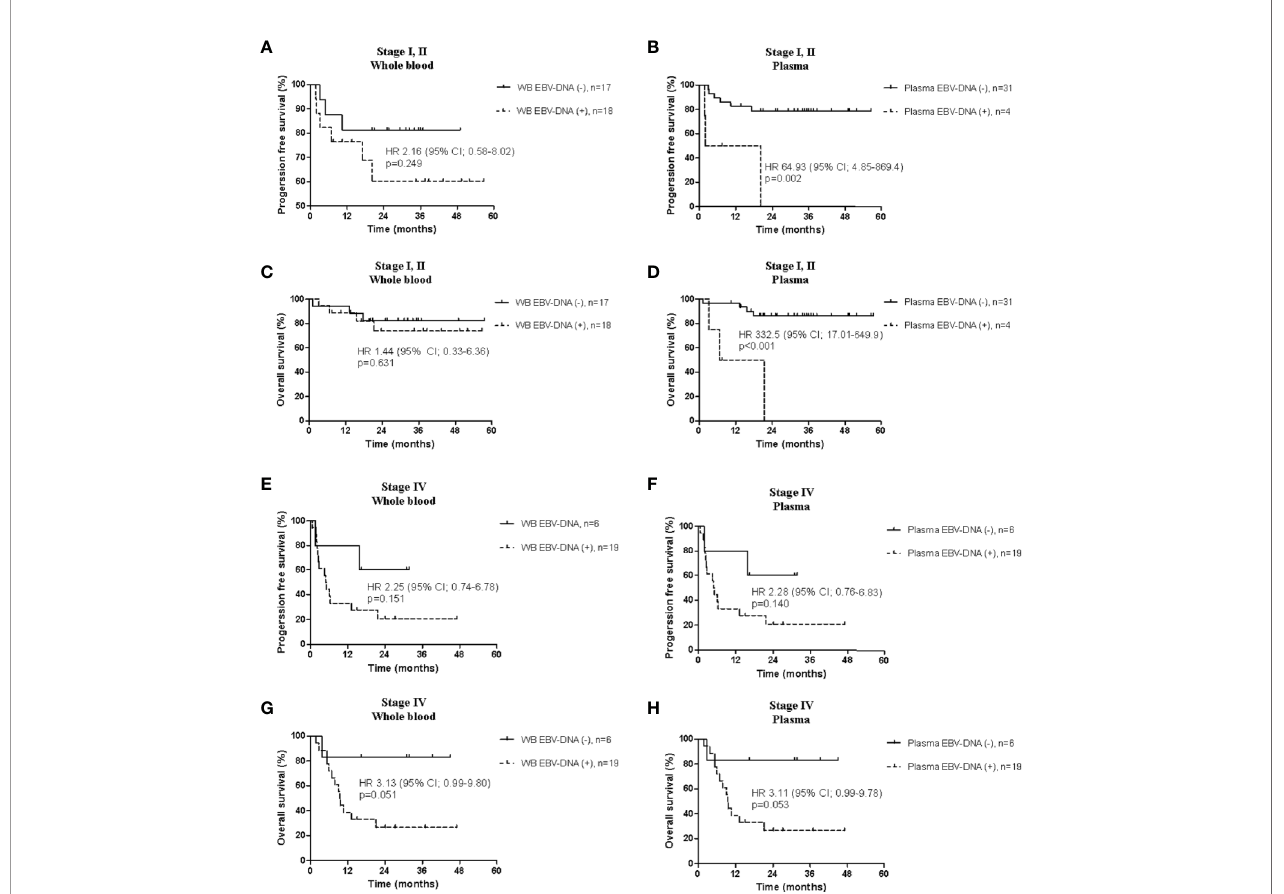
FIGURE 4 | Comparison of survival analysis between the whole blood and plasma in limited stage and advanced stage. Progression-free survival according to (A) whole blood and (B) plasma Epstein-Barr virus (EBV)-DNA, and overall survival according to (C) whole blood and (D) plasma EBV-DNA in limited disease. Progression-free survival according to (E) whole blood and (F) plasma EBV-DNA, and overall survival according to (G) whole blood and (H) plasma EBV-DNA in advanced